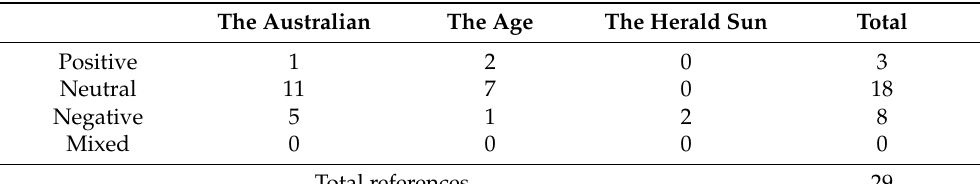
Table 13. Secular Sacred—tone of references across the newspapers. The Australian The Age The Herald Sun Total Positive 1 2 0 3 Neutral 11 7 0 18 Negative 5 1 Mixed 0